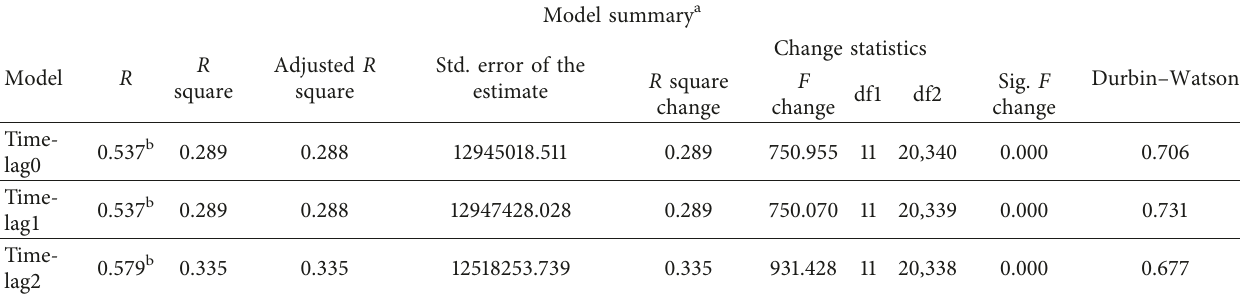
Table 10: Model summary for a DOE medium office building depending on time-lag.